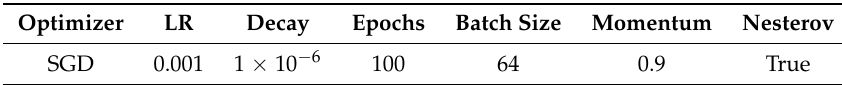
Table 3. Training